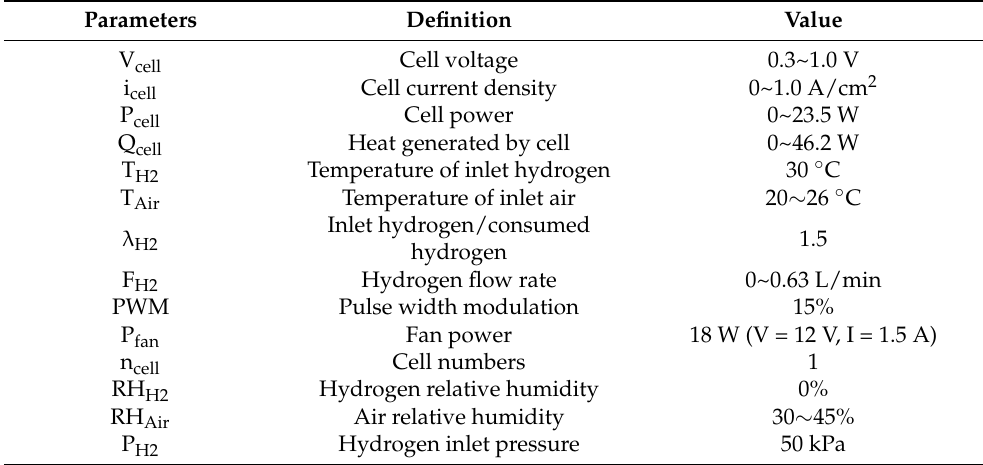
Table 3. Experimental parameters of open-cathode